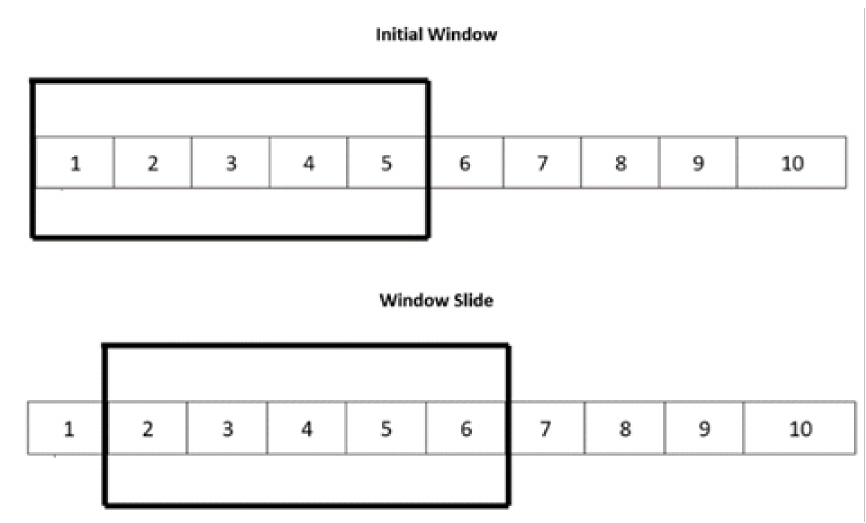
Figure 3. Process of sliding